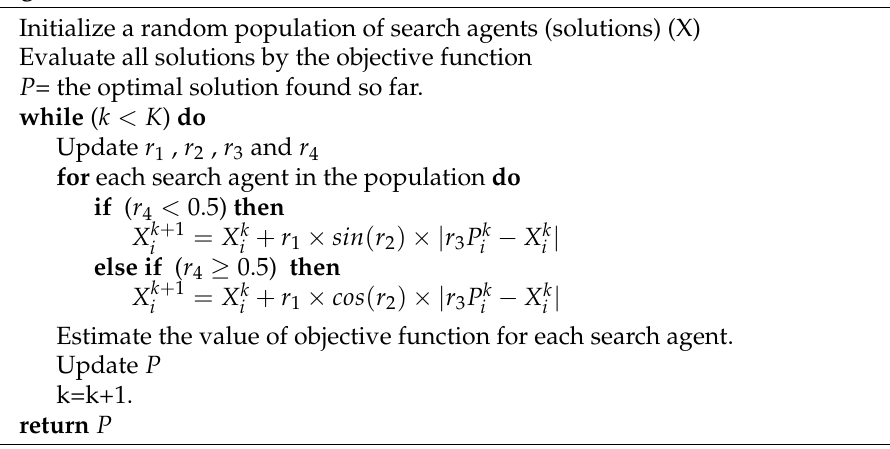
Figure 9. Decreasing pattern for the sine and cosine. Algorithm 3 Pseudo-code of